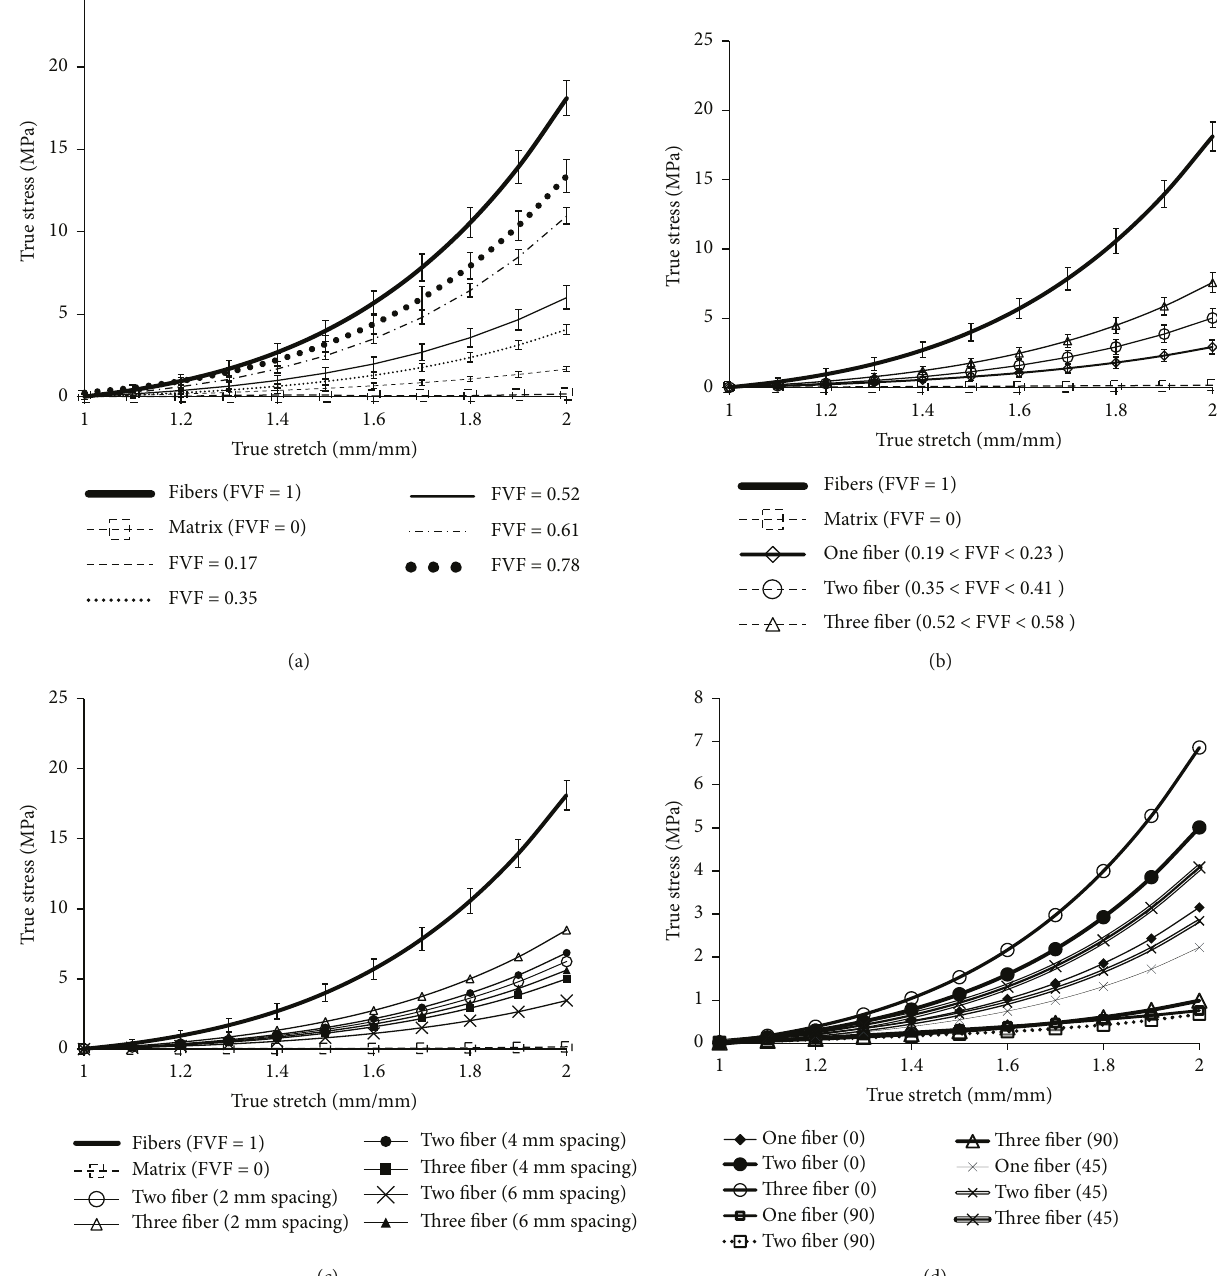
Figure 5: Soft composite material properties due to variations in (a) FVF, (b) number of fi bers, (c) fi ber spacing, and (d) fi ber